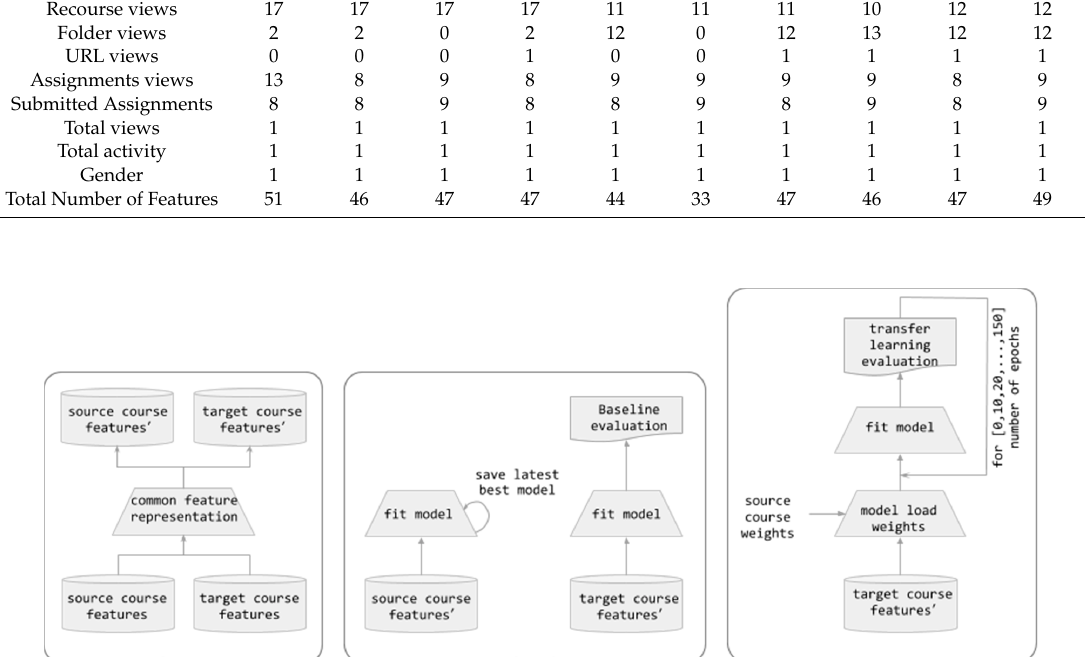
Figure 2 . The three-step process of the proposed method. Figure 2. The three-step process of the proposed Algorithm 1 : Transfer learning through paired course using deep neural networks.